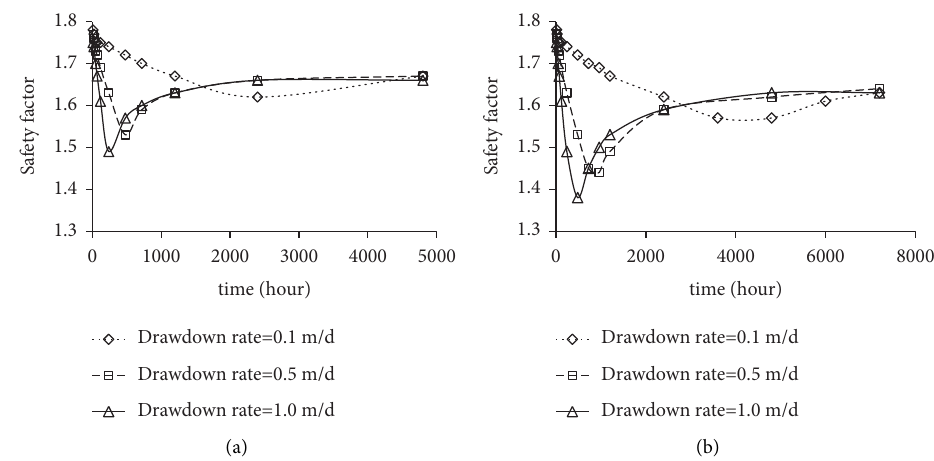
Figure 5: The stability variation versus time in the homogeneous dams (with the same slope gradients): (a) r � 0 . 415 and (b) r � 0 . 830.